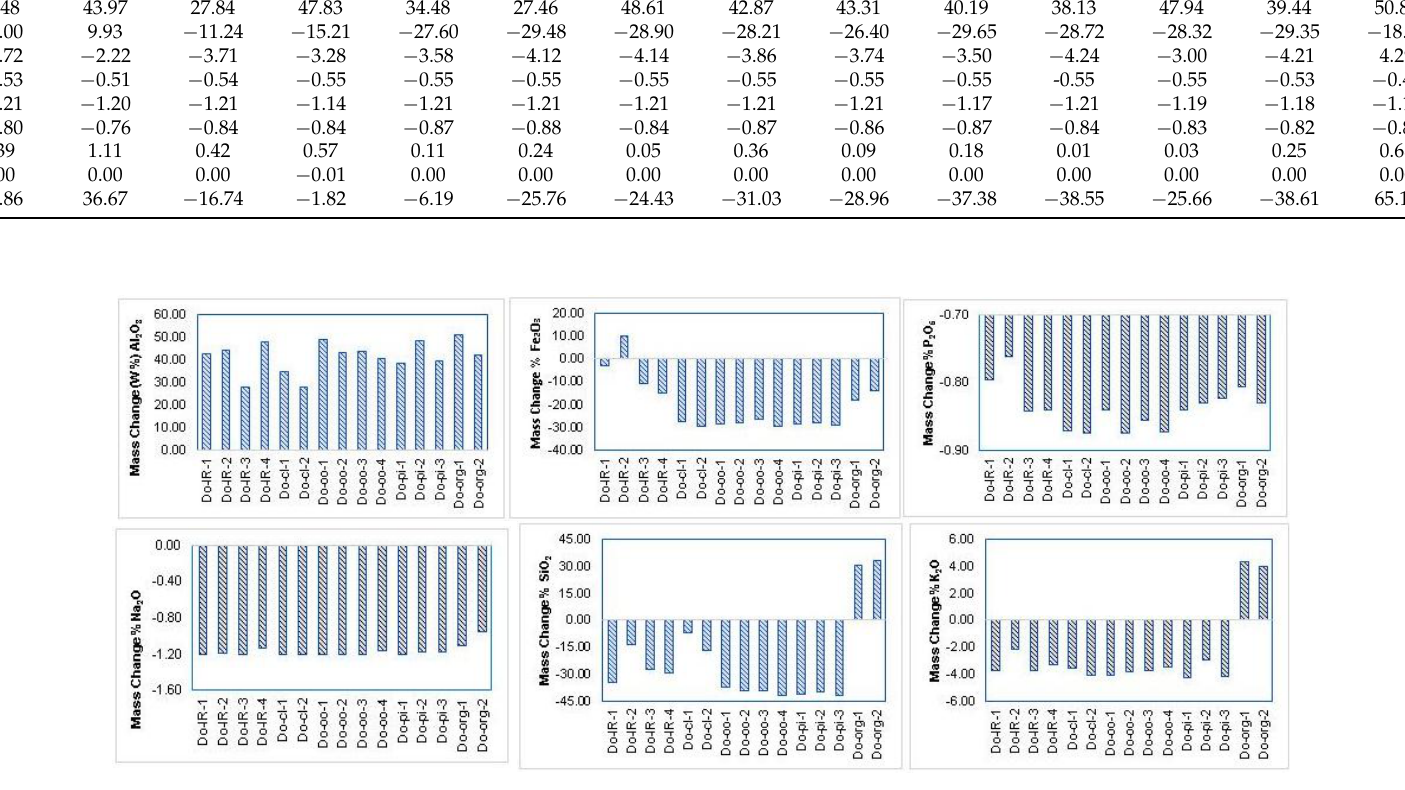
Figure 13. Mass changes in the Dopolan bauxite deposit relative to the Khaneh–Kat argillitic dolomite. The mass changes can be considered as enrichment and depletion in weight % or grams per 100 g of the argillic dolomite